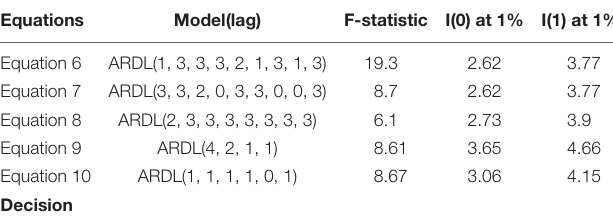
TABLE 3 | ARDL bound test results (cointegration).